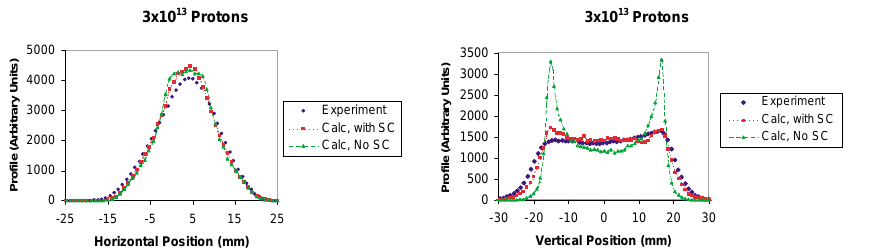
FIG. 5. (Color) The effect of the space charge on the calculated beam profiles, for the case with no closed orbit bumps during injection and at the highest intensity.